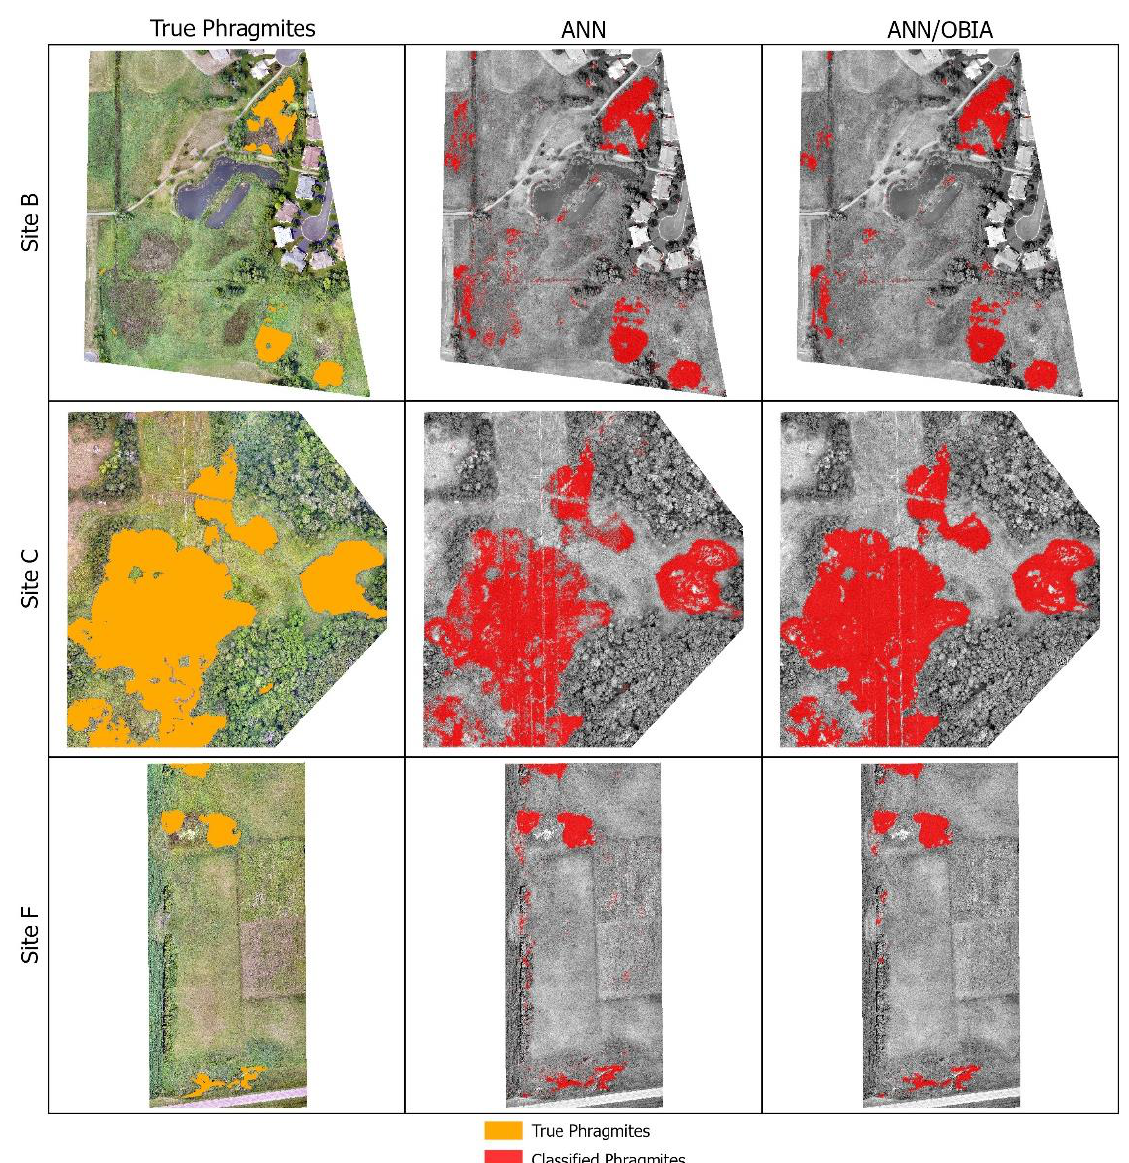
Figure 7. Classification of Phragmites (red) using an artificial neural network with and without the post-ML OBIA rule set at the three validation sites: Delano City Park (B), Chisago City property (C),